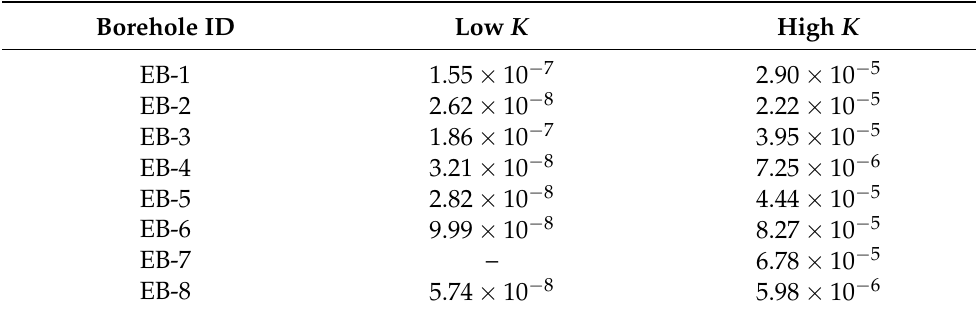
Figure 3. Core samples of subsurface sediment collected from two exploratory boreholes (EB-5 and EB-8) at the study site and the schematic of the three layer conceptual model of the subsurface deduced from analysis of the sediment. Table 2. Summary of the range in saturated hydraulic conductivity ( K ) values in m/s for sediments from each borehole (EB-1–EB-8) determined using the falling-head permeameter method. The dash (–) indicates that data are not